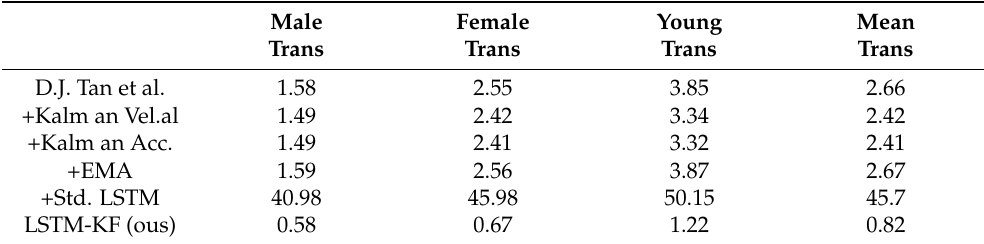
Table 2. Effects of temporal regularization on object-tracking estimations of Procapra przewalskii. The errors in translation are denoted as